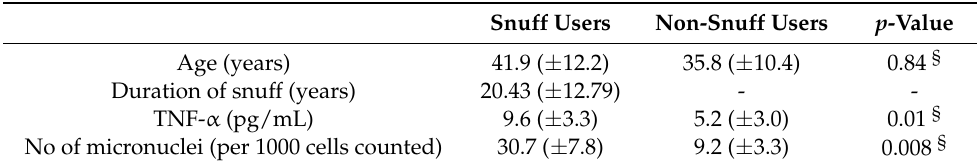
Table 2. Comparison of TNF- α and micronuclei levels among study